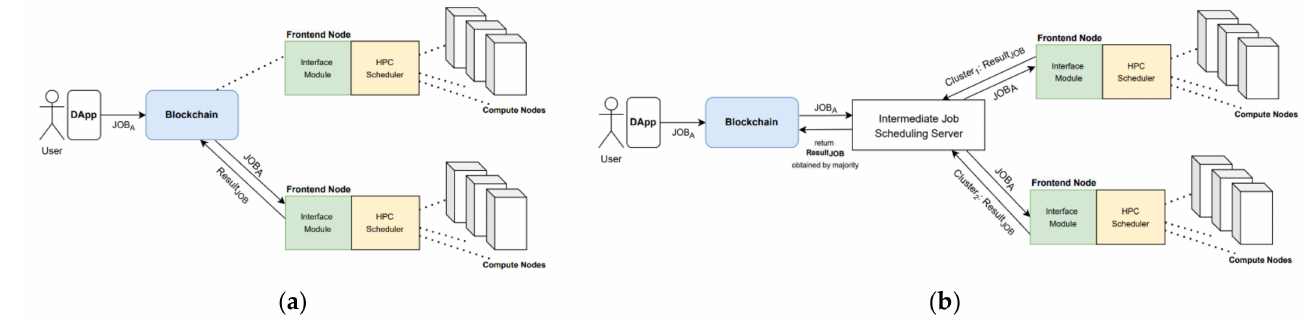
Figure 2. Computing Resources Sharing System Architecture. ( a ) Trusted System Model; ( b ) Untrust- worthy System Model. Figure 2b: In this model, we allow the registration process of HPC systems